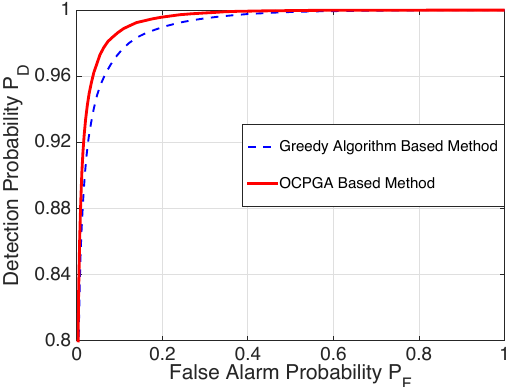
Figure 3. ROC curve for the larger-scale